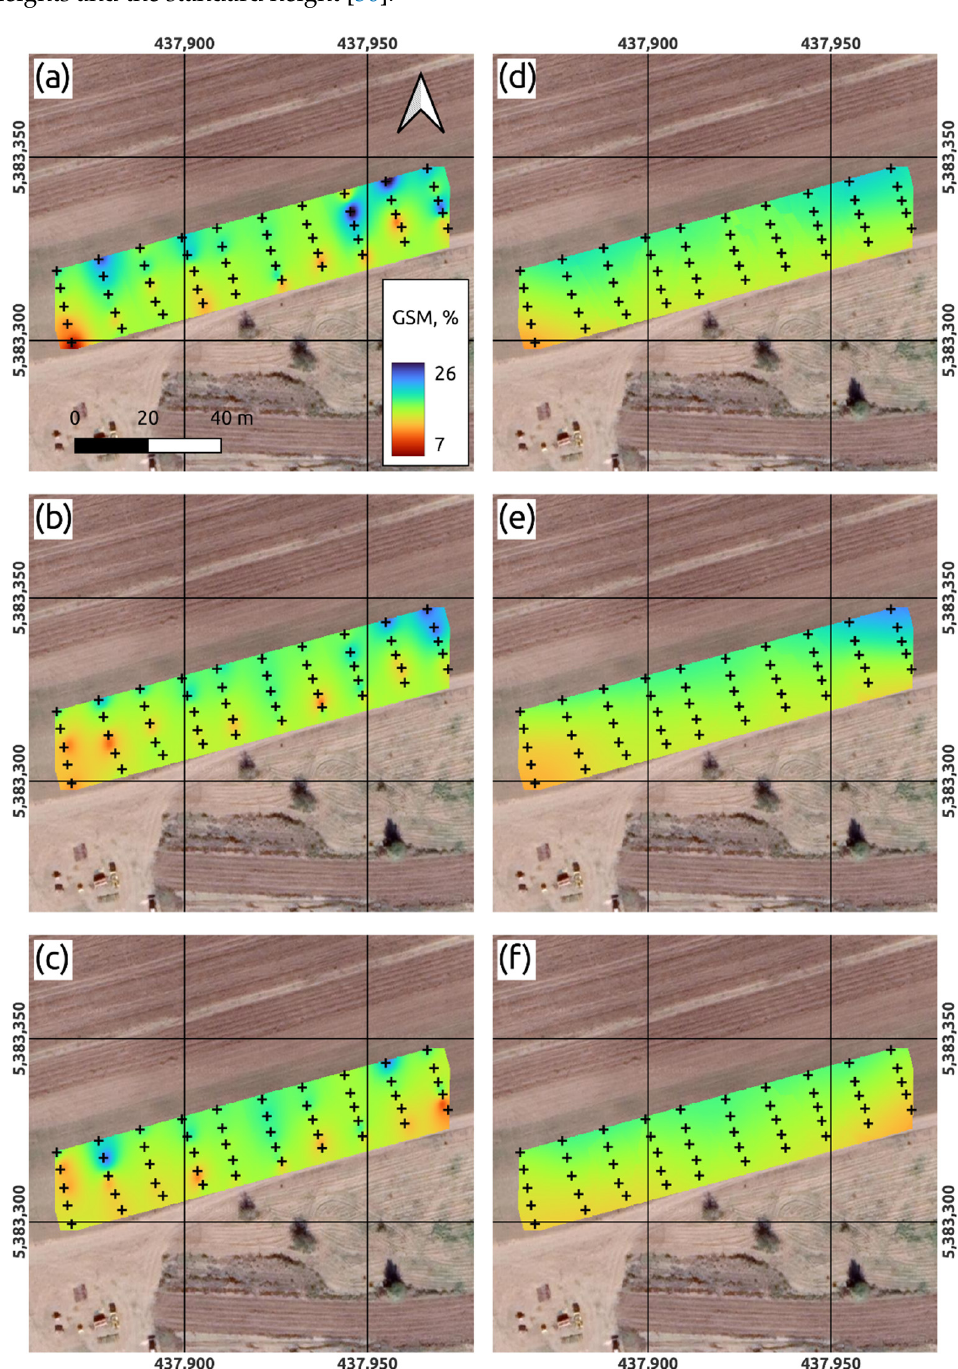
Figure 3. Maps of gravimetric soil moisture interpolated with inverse weighted distance ( a – c ) method and the deterministic Bayesian Kriging ( d – f ) approach on three corresponding depth intervals (0–15, 15–30 and 30–45 cm).